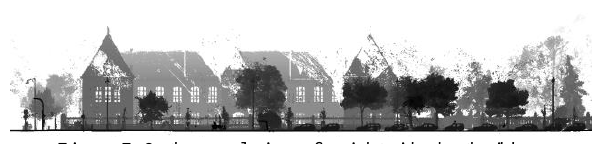
Figure 7. Orthogonal view of a right side depth ribbon